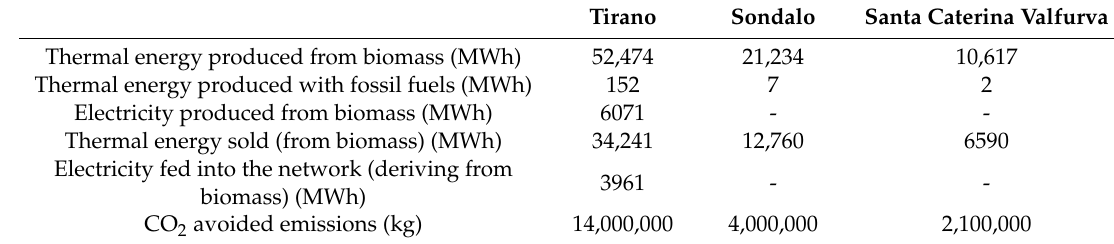
Table 4. Total energy produced during 2015 in Tirano (SO), Sondalo (SO) e Santa Caterina Valfurva (SO)